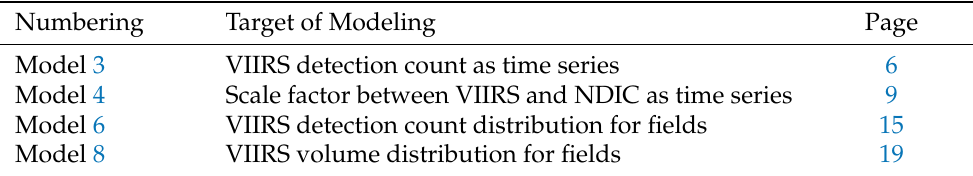
Table 2. Models developed in this